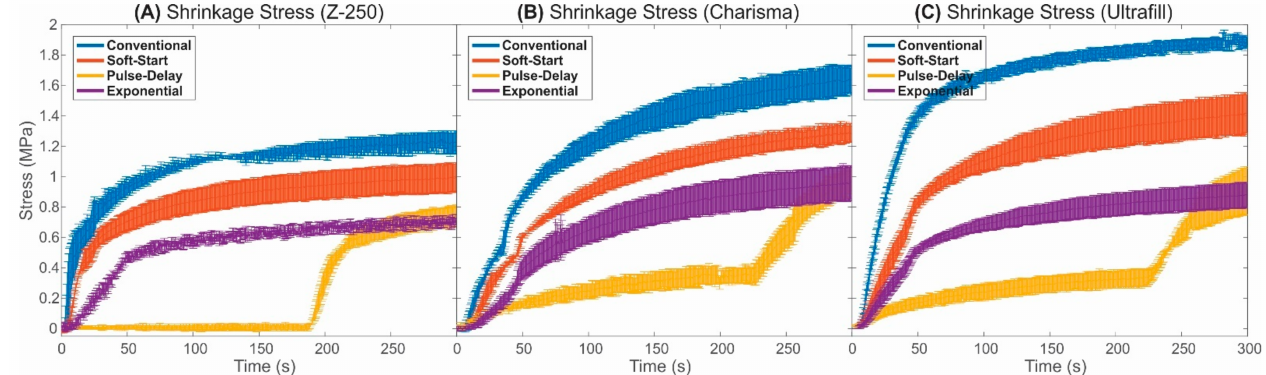
Figure 3. Shrinkage stress along the composite curing process for the resins: ( A ) Z-250; ( B ) Charisma and; ( C ) Ultrafill. Table 3. Mean and standard deviation of 30 maximum values of shrinkage stress. Different letters indicate statistically significant differences ( p -value < 0.05). Uppercase letters compare the effect of photoactivation protocol on the shrinkage stress (within lines), and lowercase letters compare shrinkage stress for each resin composite (within columns).